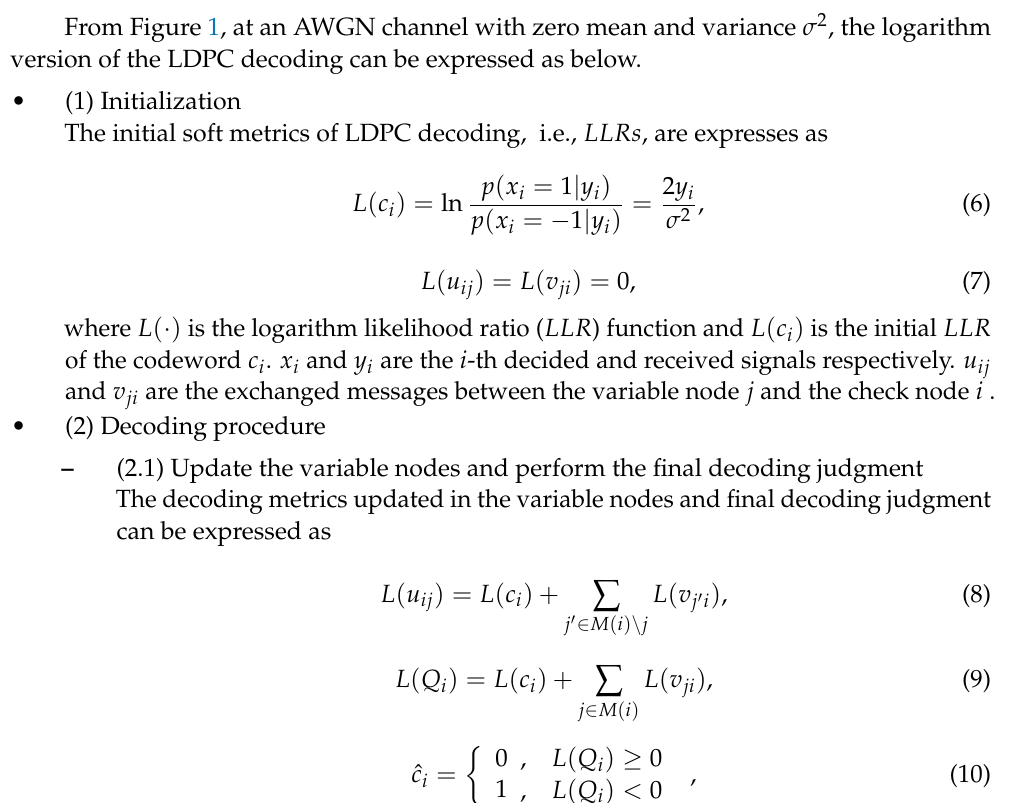
Figure 1. Schematic diagram of the LDPC soft message propagations between the variable nodes and check nodes in BP